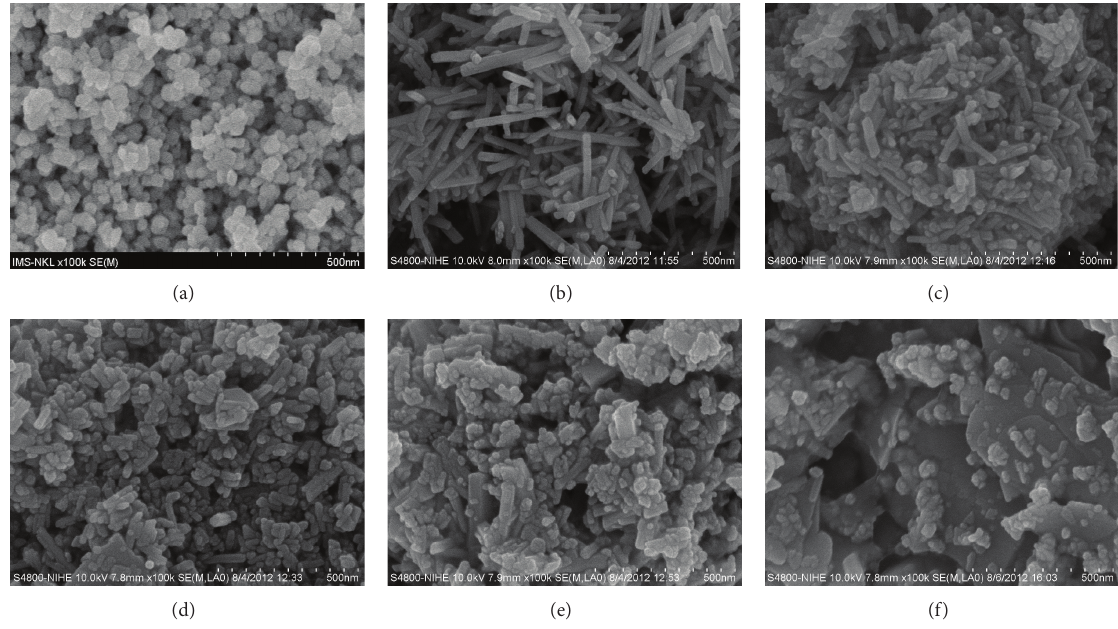
Figure 3: SEM images of different Er 3+ -doped ZnWO 4 samples: (a) 0%, (b) 2%, (c) 4%, (d) 6%, (e) 8%, and (f) 15%.